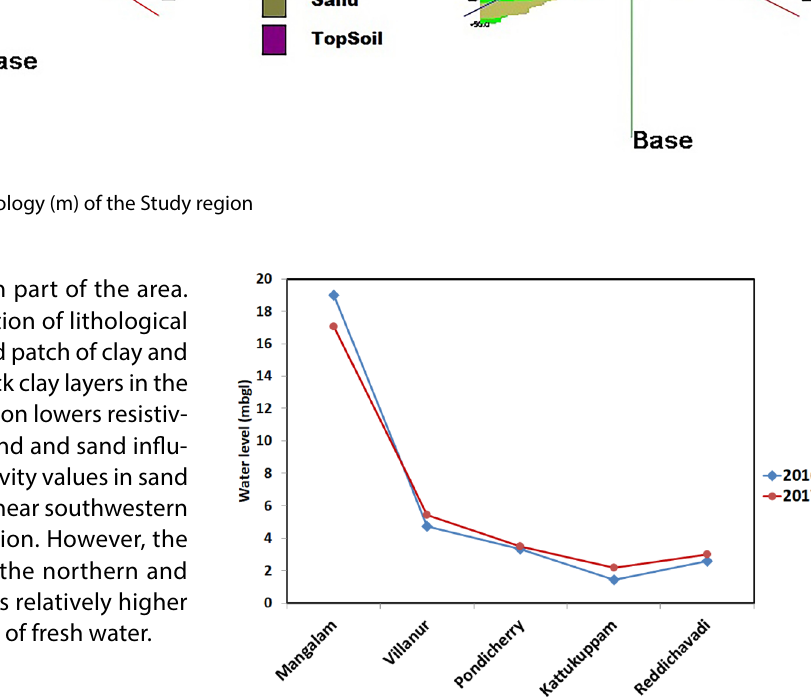
Fig. 3 Total average annual water level (mbgl) from the period of 2016 and